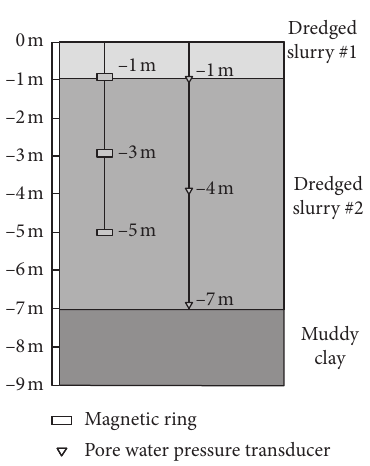
Figure 5: Elevation view of installed instruments layout.